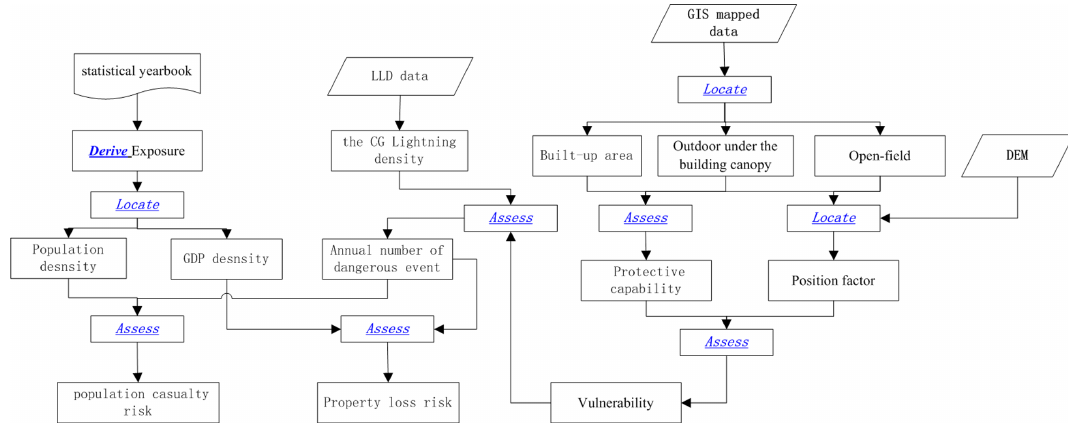
Figure 5. Schematic display of the framework for the lightning risk assessment